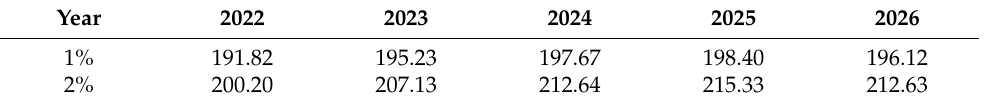
Table 19. Prediction result of water requirement with different growth rates of YEP in Hebei Province.